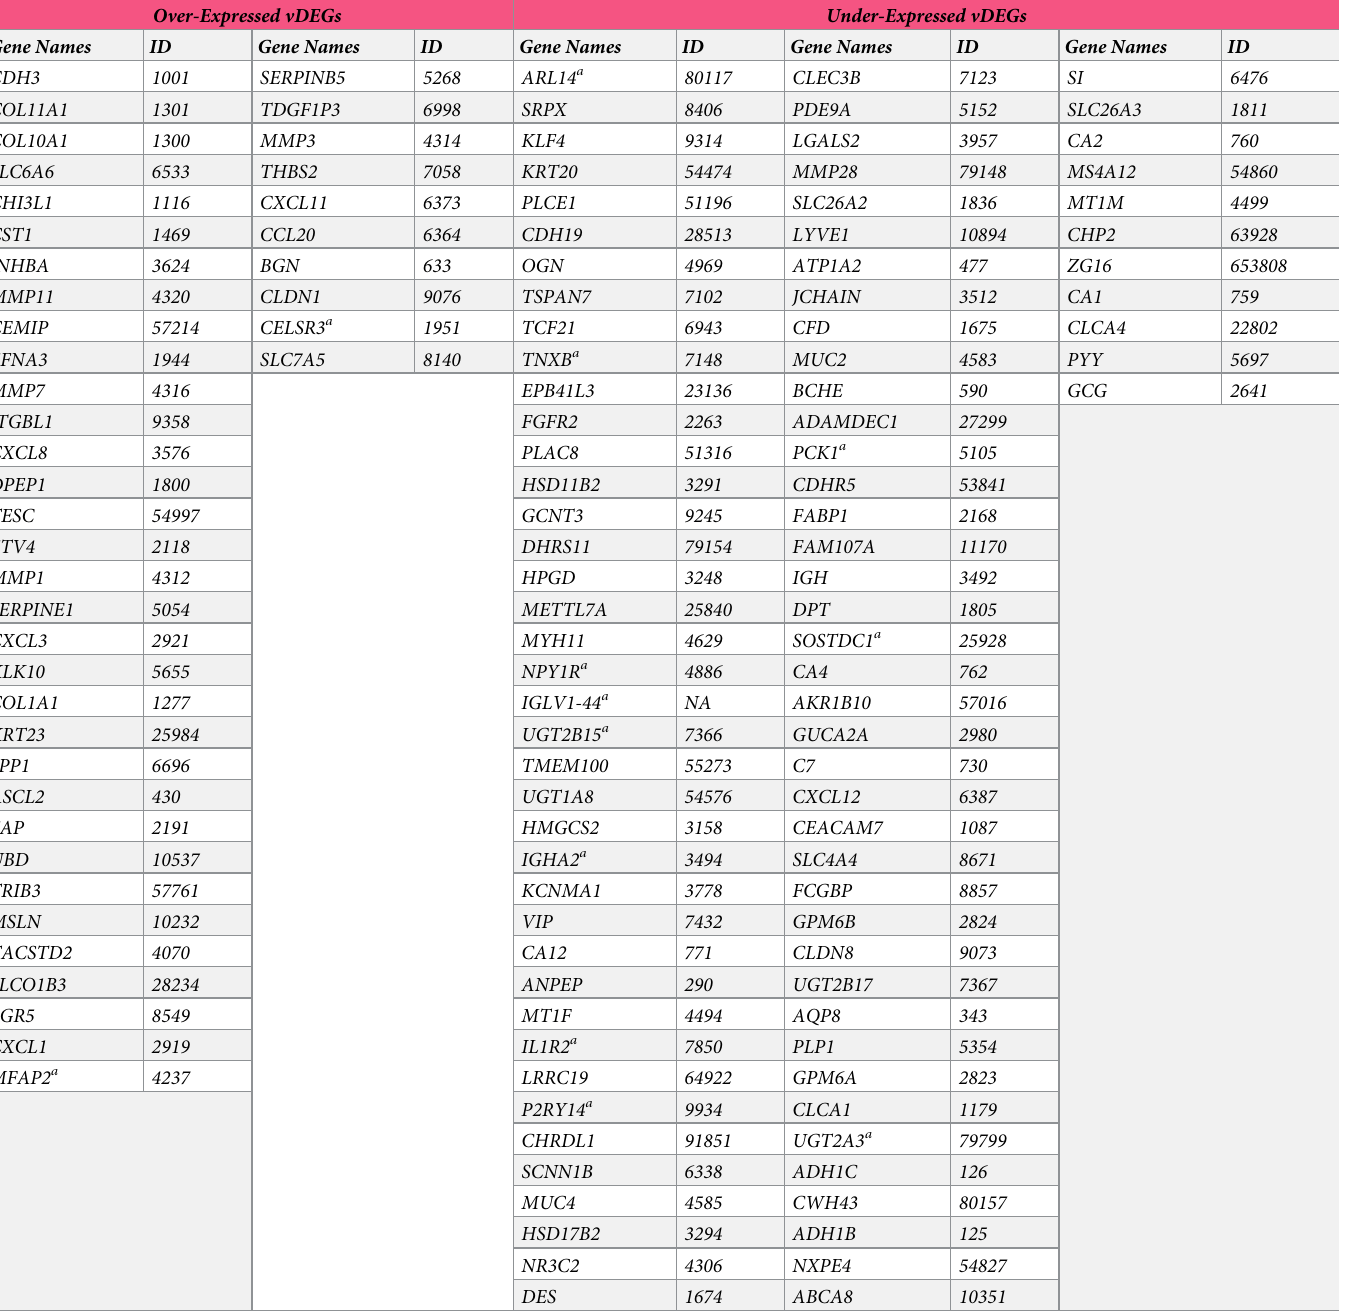
Table 2. The list of Differentially Expressed Genes are in common between discovery dataset (GSE41258) and validation dataset (GSE31905). Over-Expressed